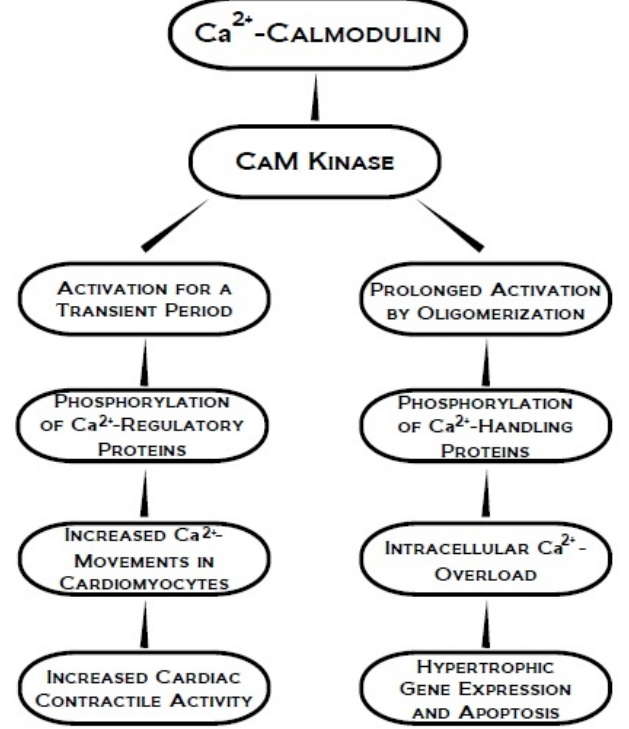
Figure 4. Transient and prolonged activation of CaM kinase in phosphorylating Ca 2+ cycling proteins for the occurrence of beneficial and detrimental effects on the